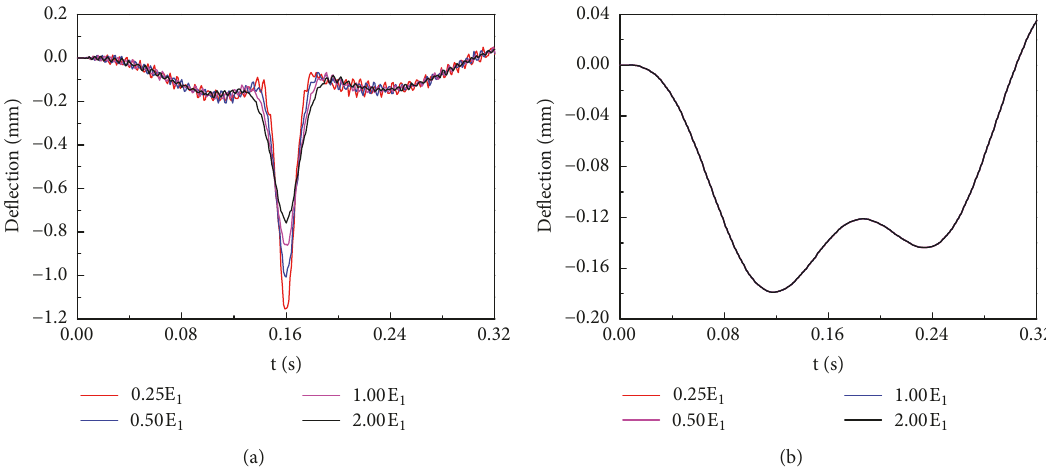
Figure 15: Comparison diagram of mid-span deflection time-history for double simply supported rail-bridge system under different stiffness of first beam: (a) first beam; (b) second